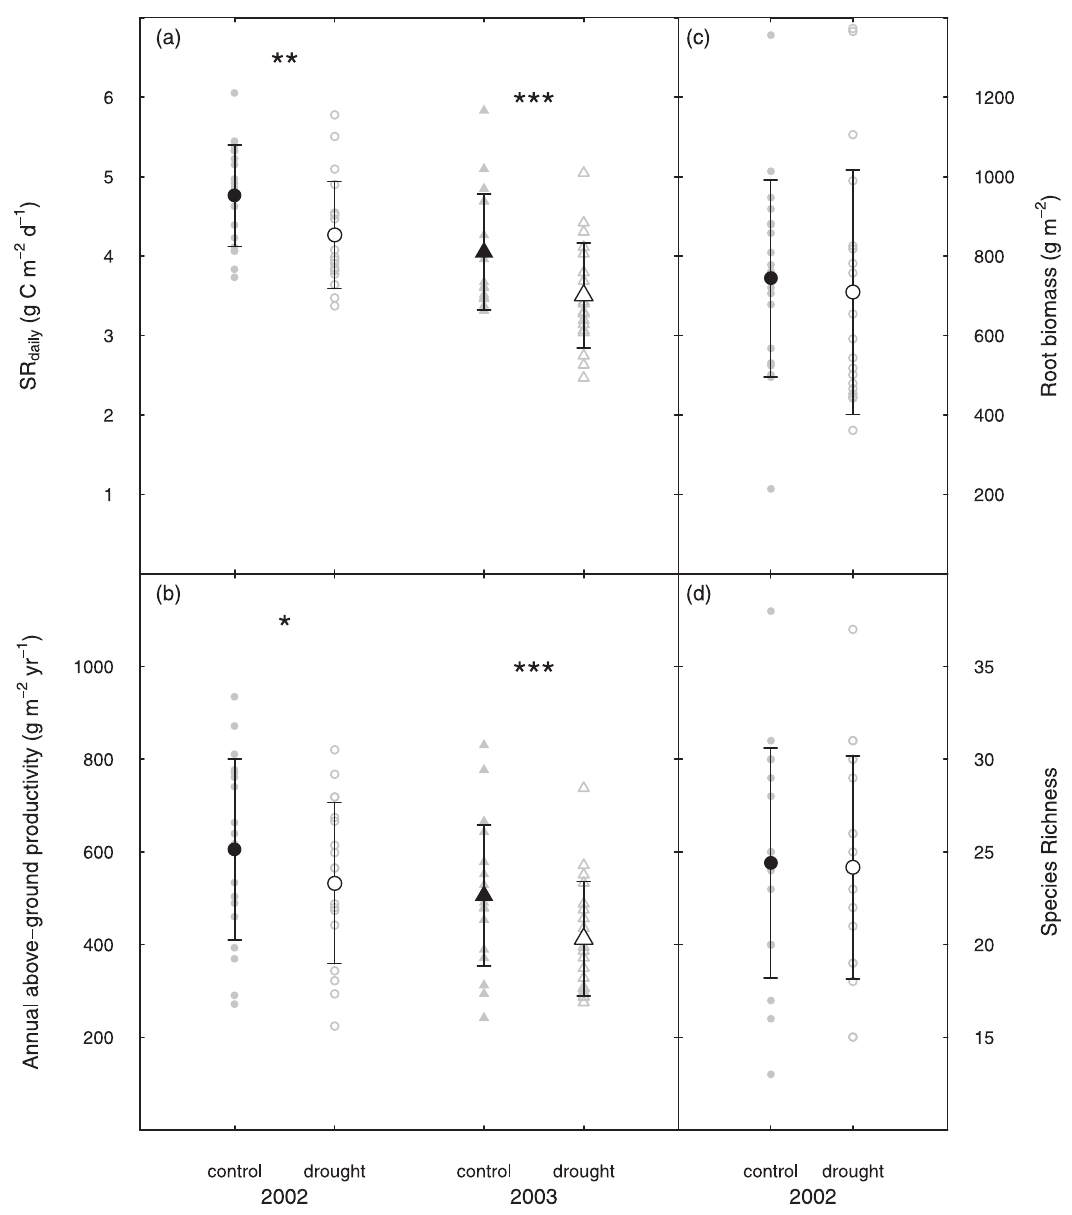
Fig 2. Soil respiration and biotic drivers under control and drought conditions. (a) mean daily soil respiration (SRdaily) and (b) mean annual above-ground productivity (c) standing root biomass and (d) species richness in 2002 (circles) and 2003 (triangles) for control (filled symbols) and drought conditions (open symbols) (mean ± SD, n = 19). Underlying grey symbols show single values. Stars indicate levels of significance: � p < 0.05, �� p < 0.01, ��� p < 0.001 (tested by ANOVA). on control plots across the 19 sites ranged from 3.3 to 6.1 g C m -2 d -1 over the two years 2002 and 2003. Mean SR across the 19 grassland sites were 17% (p < 0.001) lower on daily control plots in 2003 compared to 2002 (2002: 4.8 ± 0.6 g C m -2 d -1 , 2003: 4.0 ± 0.7 g C m -2 d -1 , mean ± SD, Fig 2a). Annual above-ground productivity on control plots across the 19 sites ranged from 242 to 935 g m -2 yr -1 during the two years 2002 and 2003. Similarly to SR , mean annual above- daily